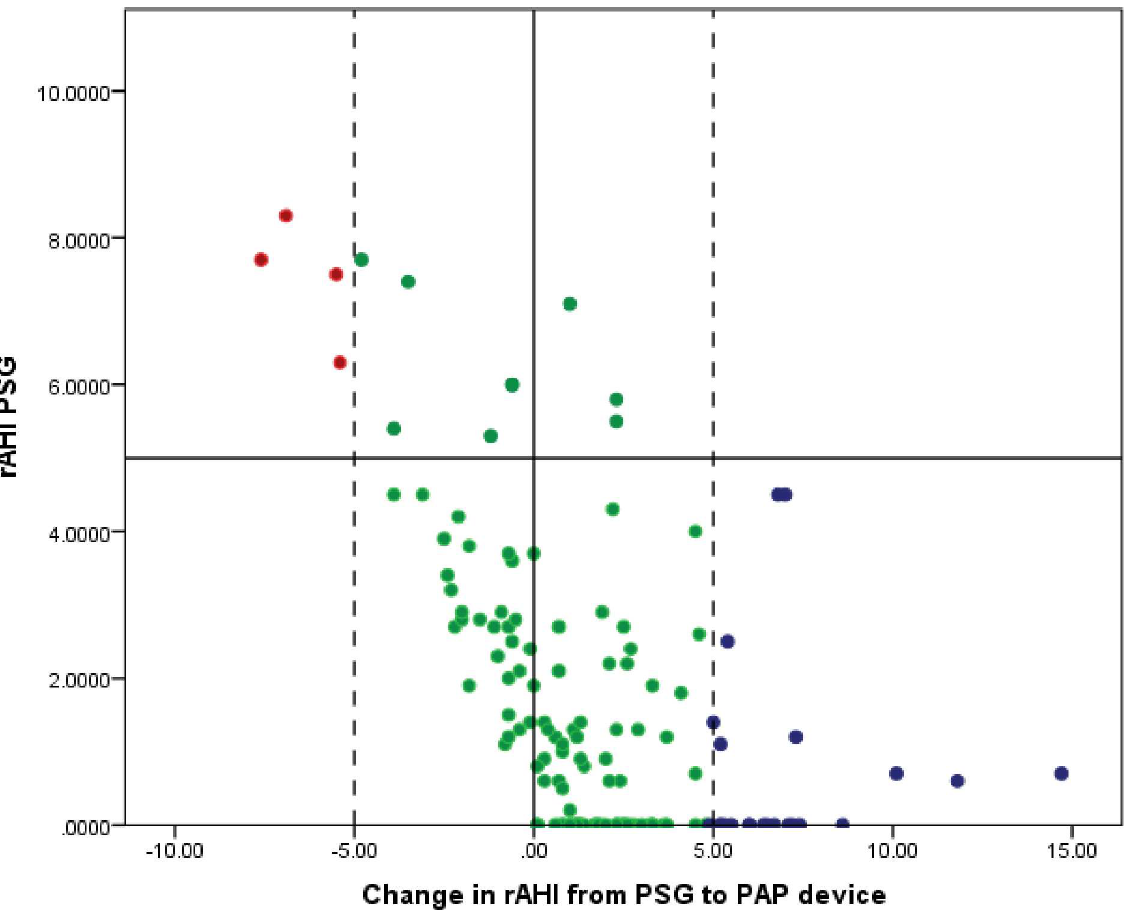
Fig 2. Differencein apnea–hypopnea index (AHI) from polysomnography (PSG) to positive airway pressuredevice (PAP).